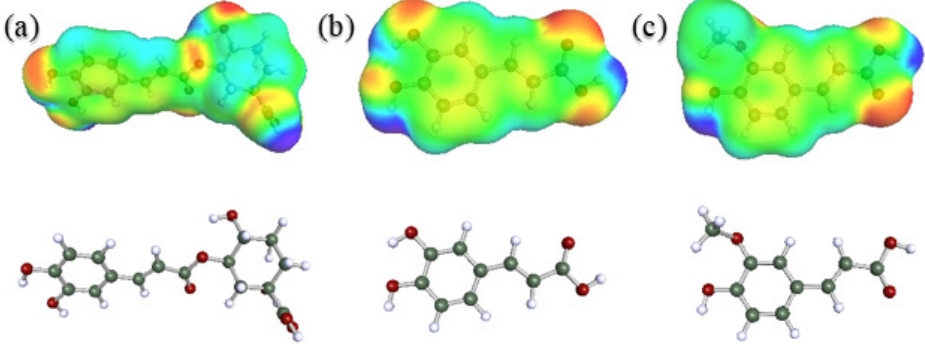
Figure 3. 3D molecular structures of ( a ) CHA, ( b ) CAF, and ( c ) FA and their charge density (elec- tronegative zone in red, electropositive zone in blue and neutral zone in green).